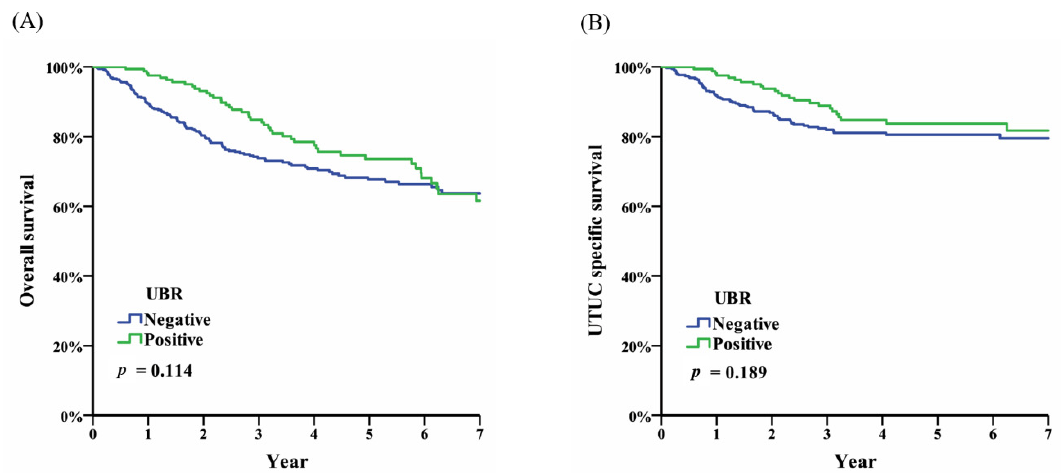
Figure 1. ( A ) Overall survival of upper tract urothelial carcinoma (UTUC); and ( B ) UTUC-specific survival stratified by urinary bladder recurrence (UBR).